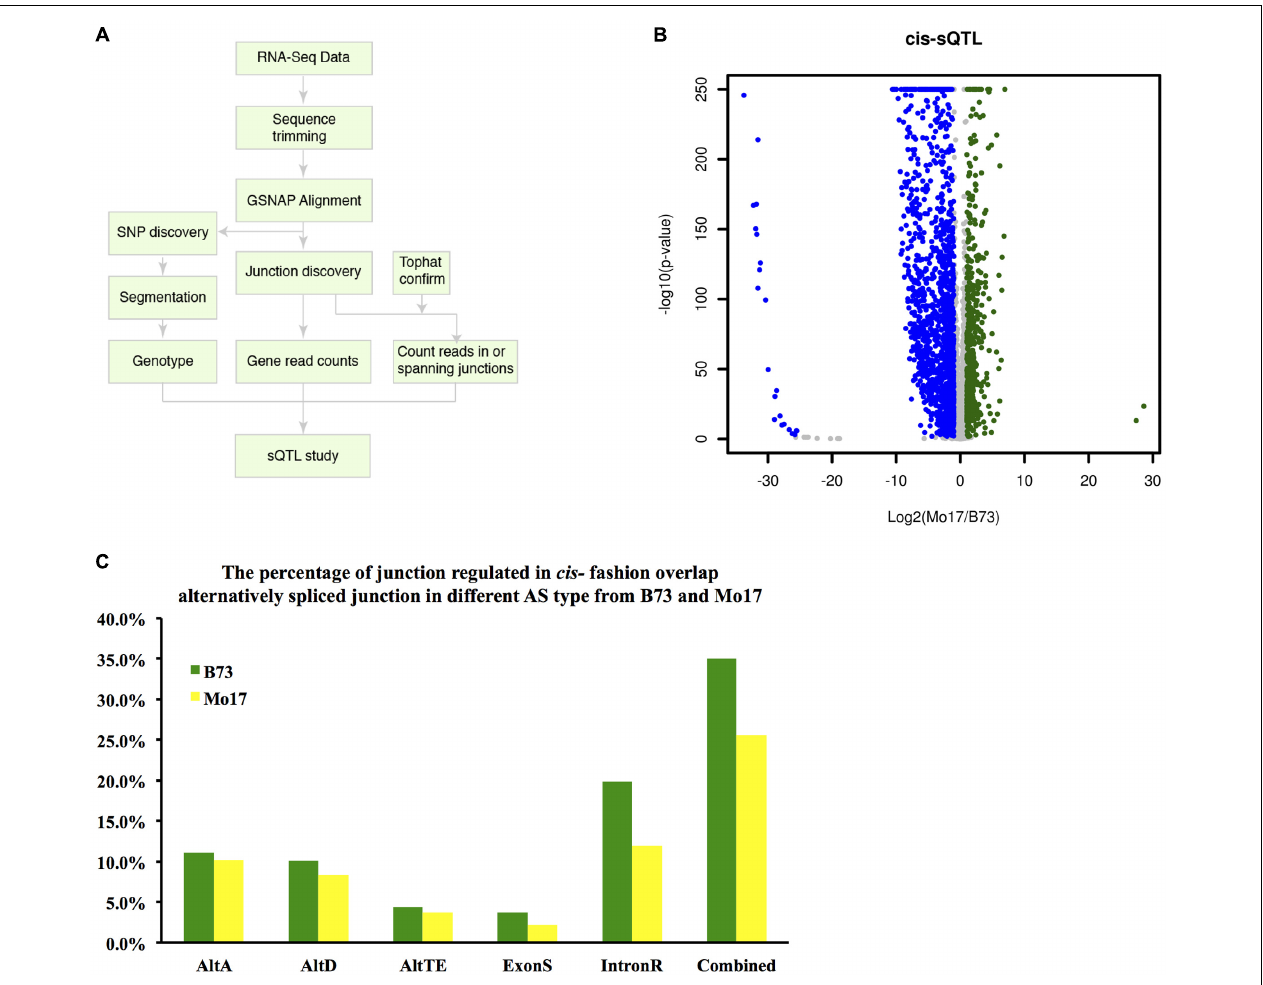
FIGURE 6 | Cis -sQTL analysis. (A) Flow chart describing the splicing QTL analysis. (B) Cis- sQTL results. Blue indicates higher expression in B73 (more intron junction read coverage), while green indicates higher expression in Mo17 (more intron junction read coverage). (C) Overlap between cis- sQTL junction and the alternatively spliced junction in each AS events in genotype B73 and